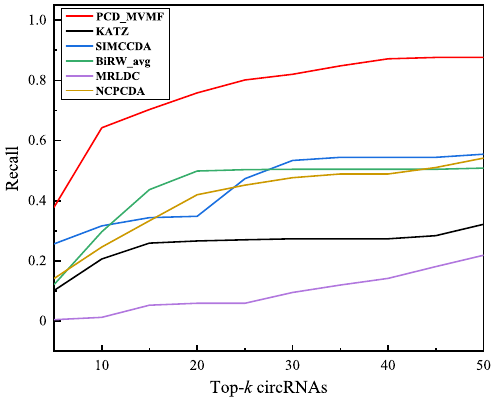
Fig. 5 Average recall of the test set at each Top- k position on querying diseases.